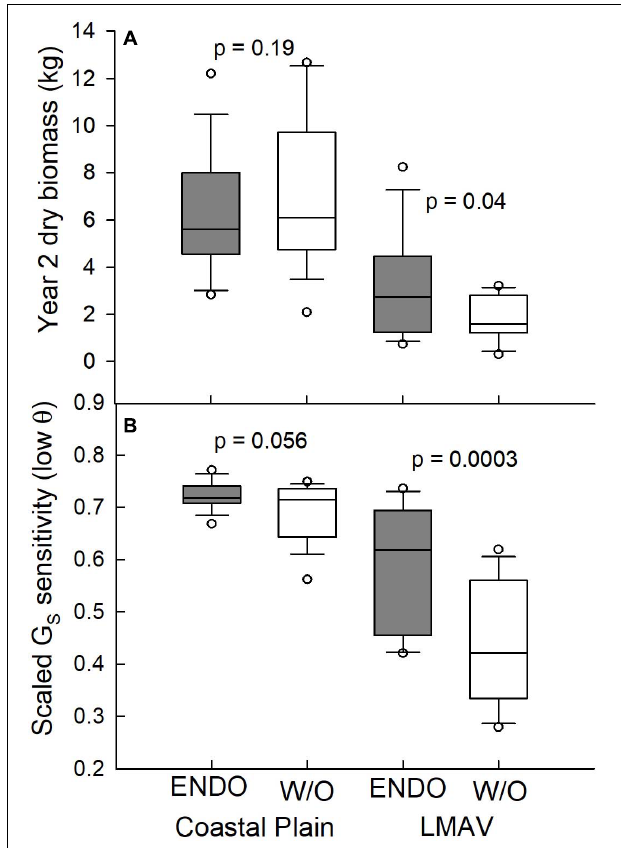
FIGURE 4 | (A) Year two dry biomass (kg), and (B) scaled canopy stomatal conductance (G S ) sensitivity at low soil moisture ( θ ; cm 3 cm − 3 ; bottom panel) for the Coastal Plain (left) and LMAV (right) field sites across all varietals inoculated with endophytes (ENDO) and those without the endophyte inoculation (W/O). p -Values for endophyte ANOVA comparisons are shown above